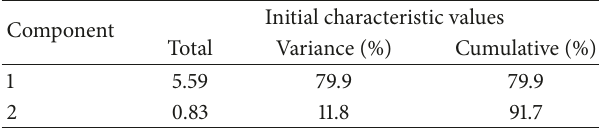
Table 2: Characteristic values and variance contributions from the principal component